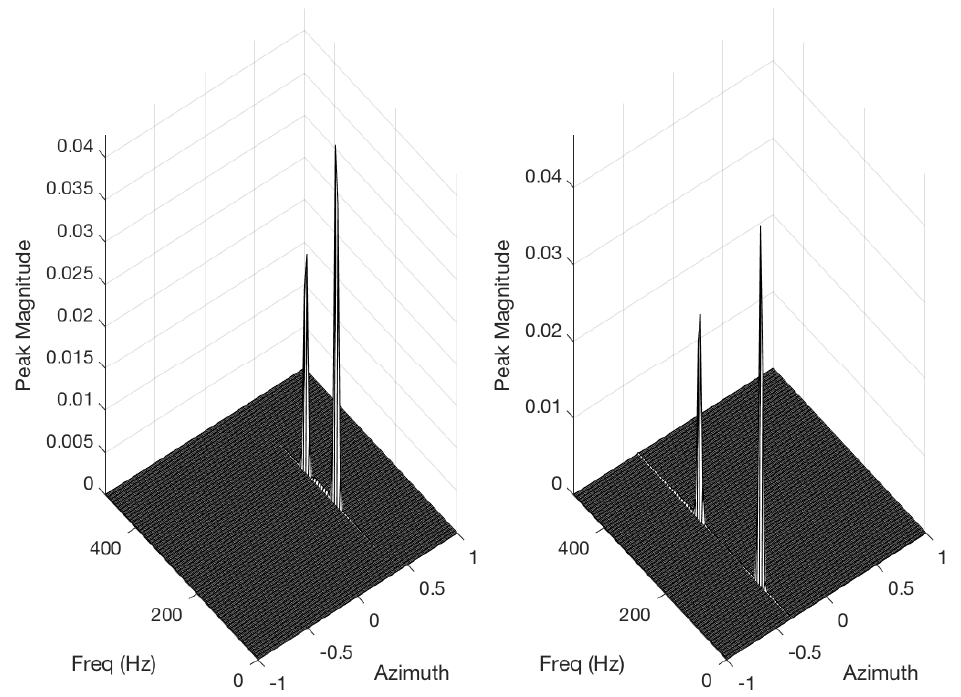
Figure 6. Separated Azimugrams using Redress: both of the azimugrams have peaks at the correct gain for the 300 Hz